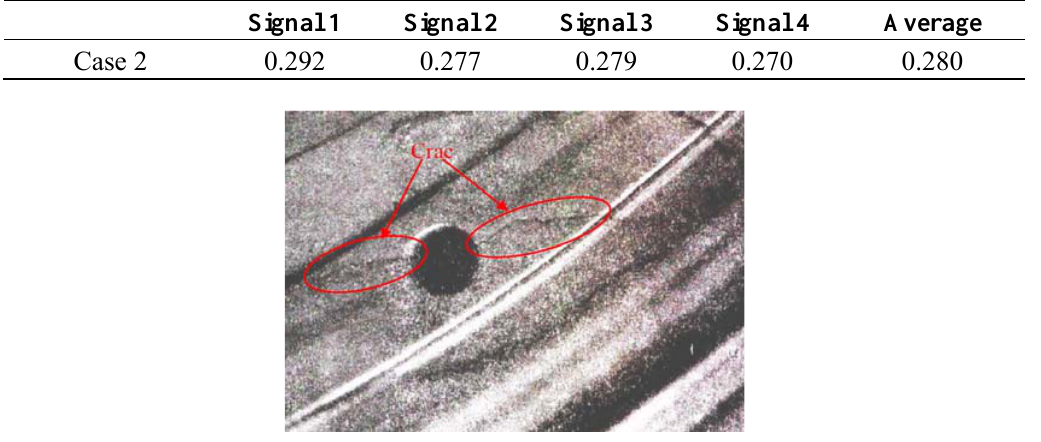
Figure 20. The photograph of this rotor with the crack fault on the pressure